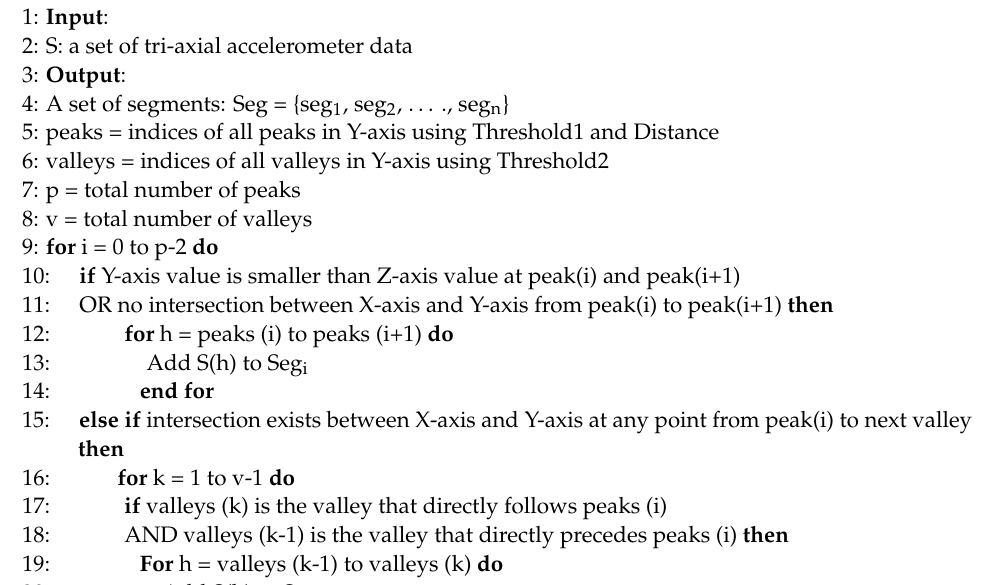
algorithm is a set of tri-axial accelerometer data S, which is divided into multiple segments. The “for” loop in lines 9–28 represents the process of determining the type of boundaries in all peaks except the last one. The “if” and “else if” statements in lines 10–14 and 15–23, respectively, examine the signal’s characteristics in each peak and divide the signal using peak or valley boundaries. Lines 28–36 repeat the process for the last peak using only valley